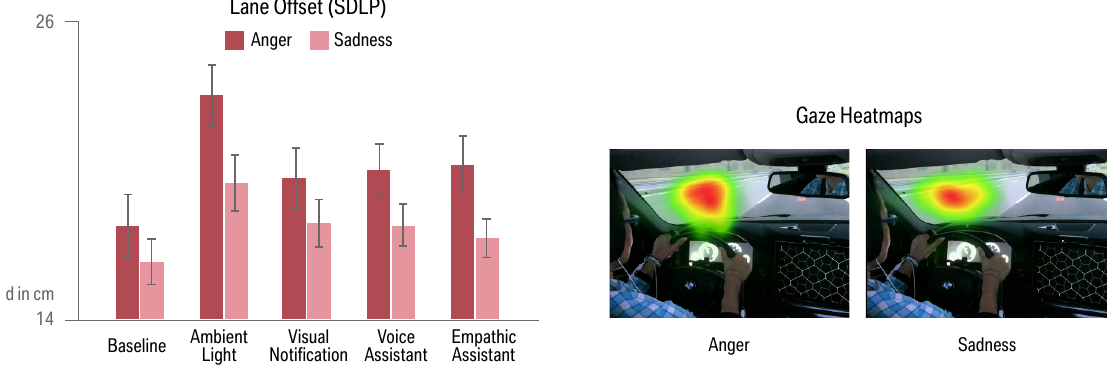
Figure 4. The standard deviation of lane position (SDLP) shows that angry drivers have higher lateral offsets than sad drivers ( left ). The strategies also have effects on SDLP: especially concept Ambient Light seems to be distracting. Participants in the Anger group also showed more agitated gaze behavior ( right